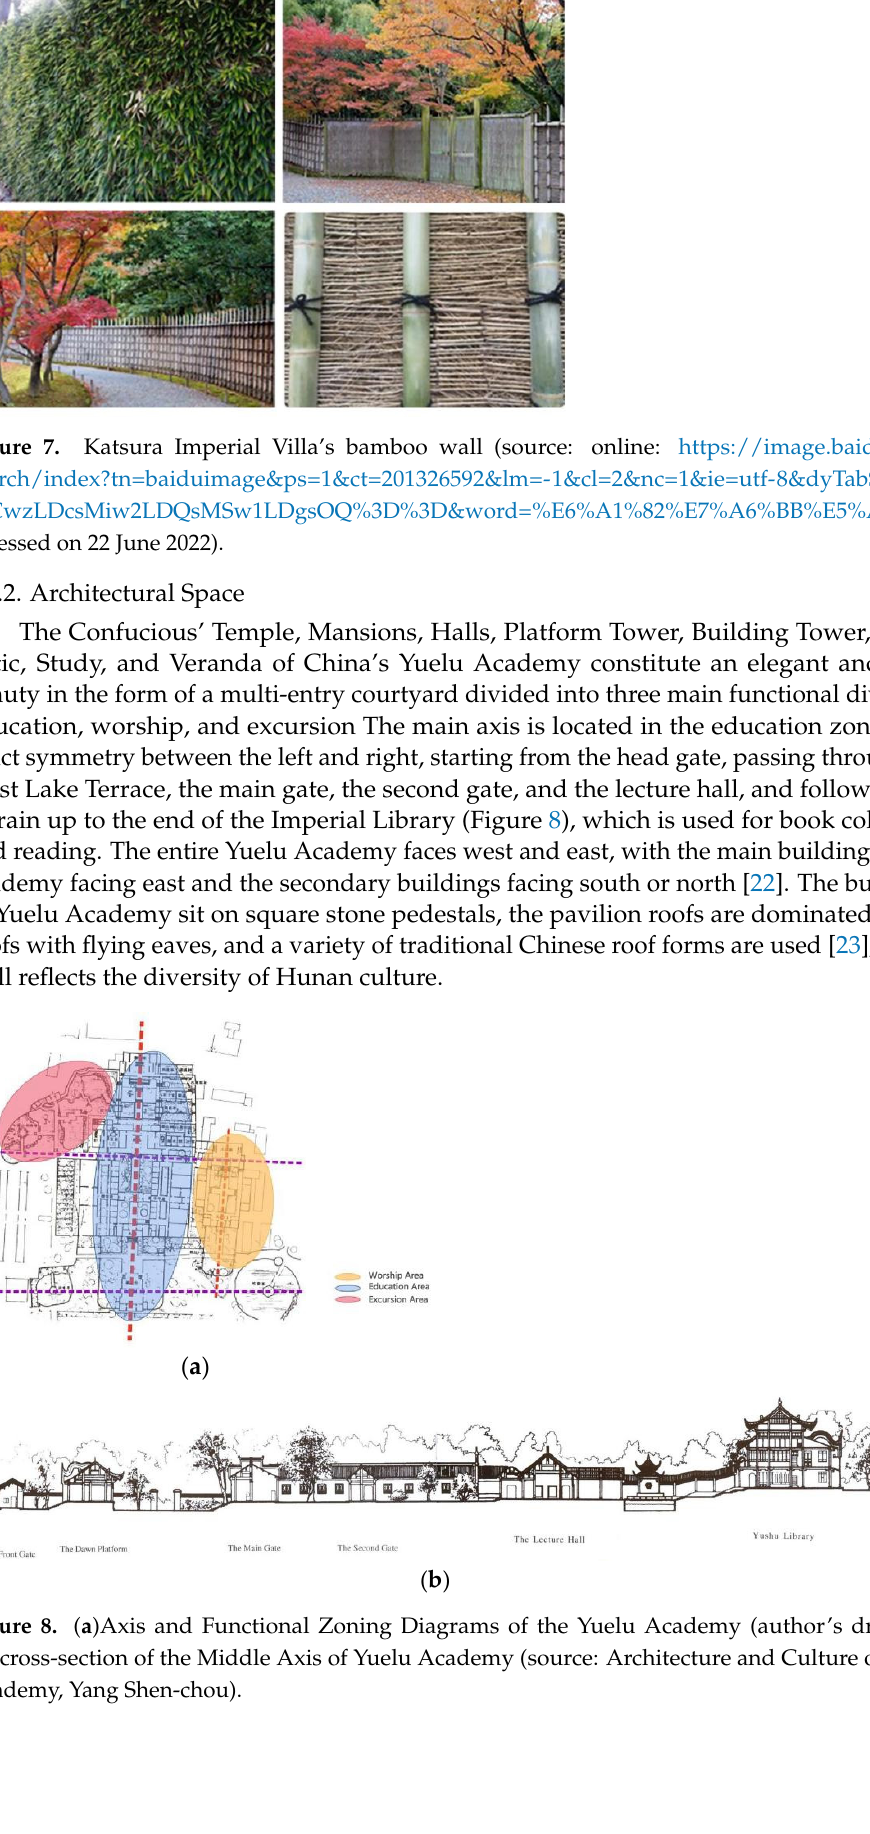
( c ) ( d ) Figure 9. ( a ) Axis Map of Pingshan Academy (source: Lee Sang-hae); ( b ) Chung Tak Hall, Pingshan Academy (source: Lee Sang-hae); ( c ) Pingshan Academy (source: Lee Sang-hae); ( d ) sim- ple element of Pingshan Academy (source: Lee Sang-hae.